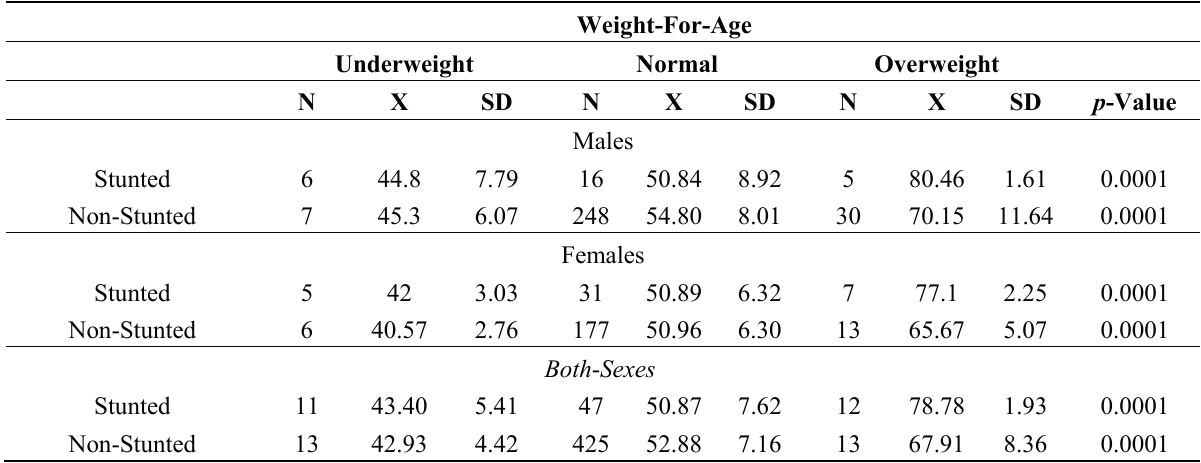
Table 4. Comparison between stunted growth and nutritional groups by weight for age.